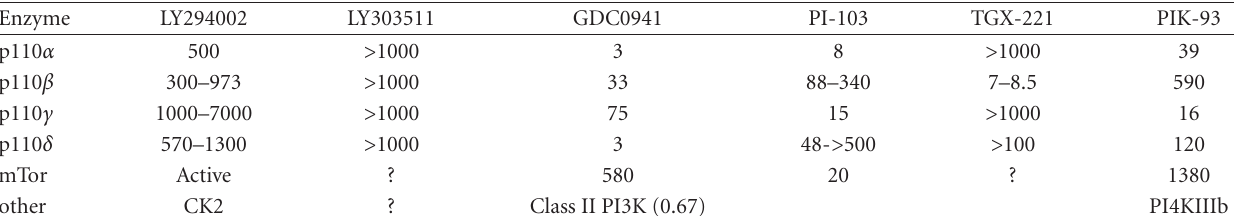
Table 1: Activities of pharmacologic inhibitors used in this study (IC 50 in nM).